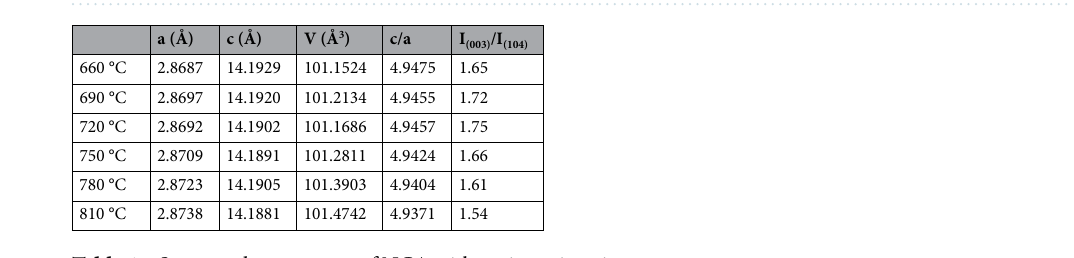
Table 1. Structural parameters of NCA with various sintering